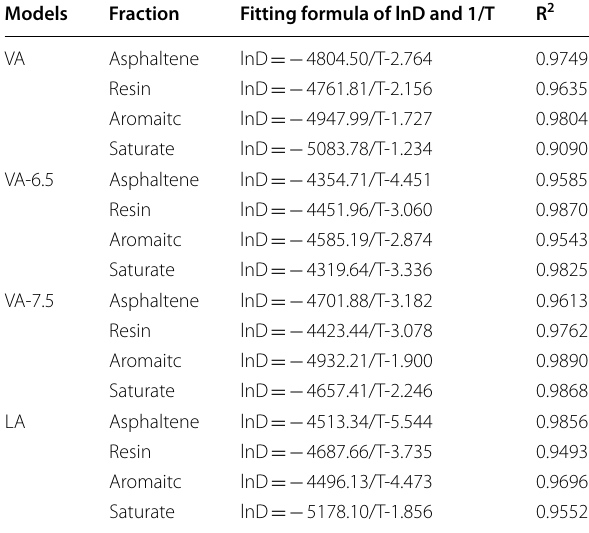
Table 3 Relationship between the Diffusion Coefficient of the SARA Components and System Temperatures